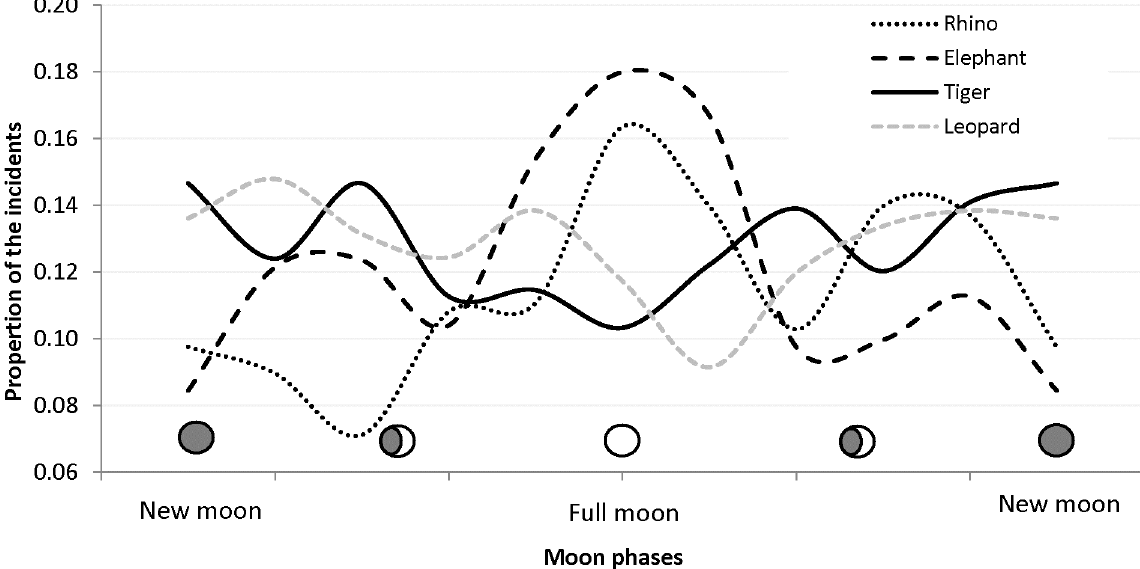
Fig 3. Proportion of the reported human-wildlife interactions with elephant, rhino, tiger and leopard in Chitwan NP between 2001 and 2015 plotted over the lunar days.